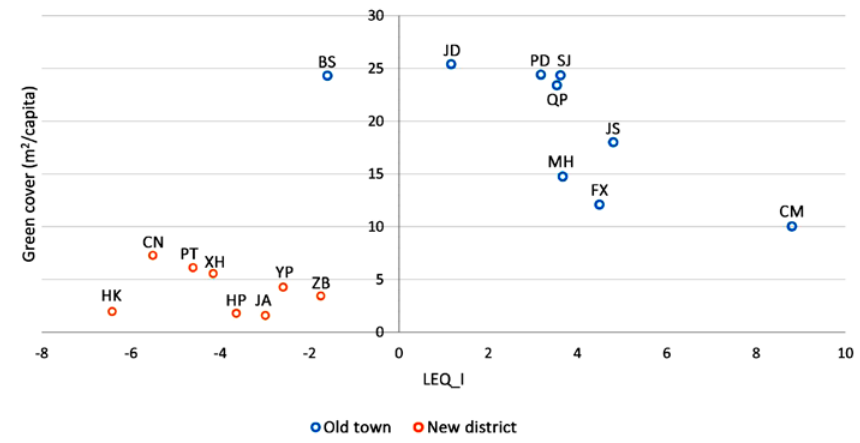
Fig. 7. UGS LEQ and per capita green cover